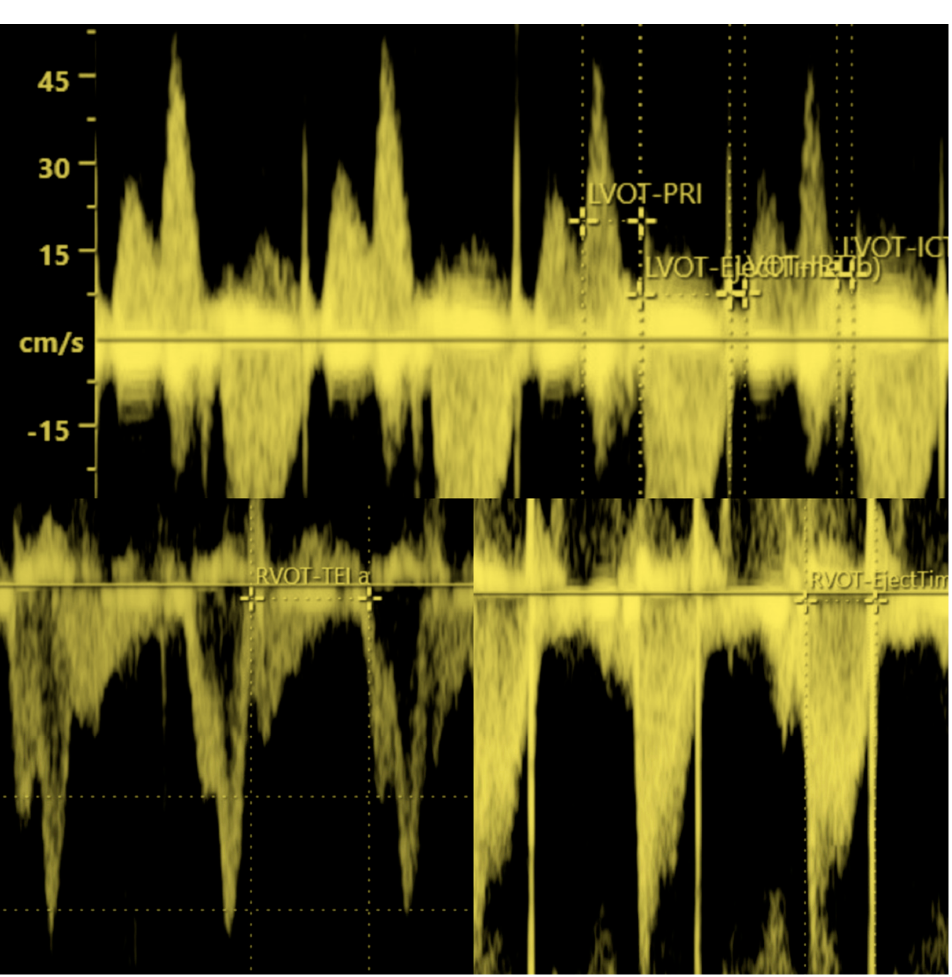
Figure 2. Picture above: Color Doppler waveforms across the mitral and aortic fetal valves (the clicks of aperture and closure of the valves are used to identify time periods of the cardiac cycle. Myocardial Performance Index (Tei index) is defined as isovolumetric contraction time (ICT) plus isovolumetric relaxation time (IRT) divided by the ejection time (ET). The E wave represents passive ventricular filling and A wave represents active ventricular filling. Mechanical PR interval is measured between the onset of atrial contraction (A-wave) and the onset of ventricular contraction (V-wave) and establishes atrioventricular time interval). Picture on the bottom left: Doppler waveforms across the tricuspid fetal valve (pulmonic flow is not evident across the tricuspid valve). E corresponds to early diastolic peak velocity and A wave corresponds to atrial contraction peak velocity. The Doppler clicks of aperture and closure of the valves are used to identify Tei a for the right ventricle. Picture on the bottom right: Measurement of the ejection time of the right fetal ventricle. This photo